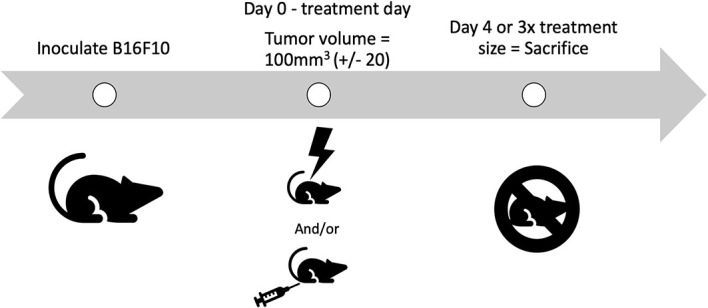
Schematic of the study design. B16-F10 cells are inoculated intradermally, with animals placed on study on day 0, when their tumors reach treatment size. Animals receive their treatment on day 0, either PBS, radiation, Cowpea mosaic virus (CPMV), or the combination. Two cohorts of animals are used for each treatment. One cohort is removed on day 4, for molecular and cellular investigation (n = 4–6), and the other cohort is removed once the tumors reach 3x the volume when treated (n = 4–5).